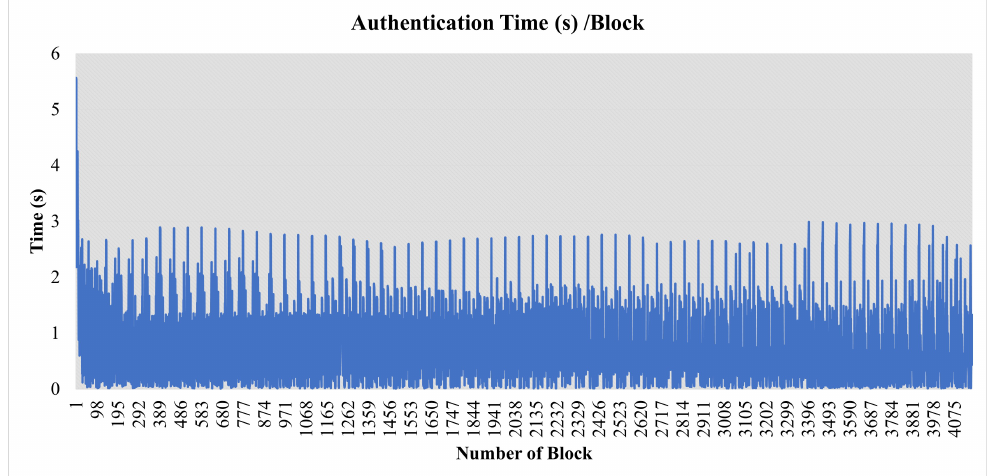
Figure 9. Nodes Containers on